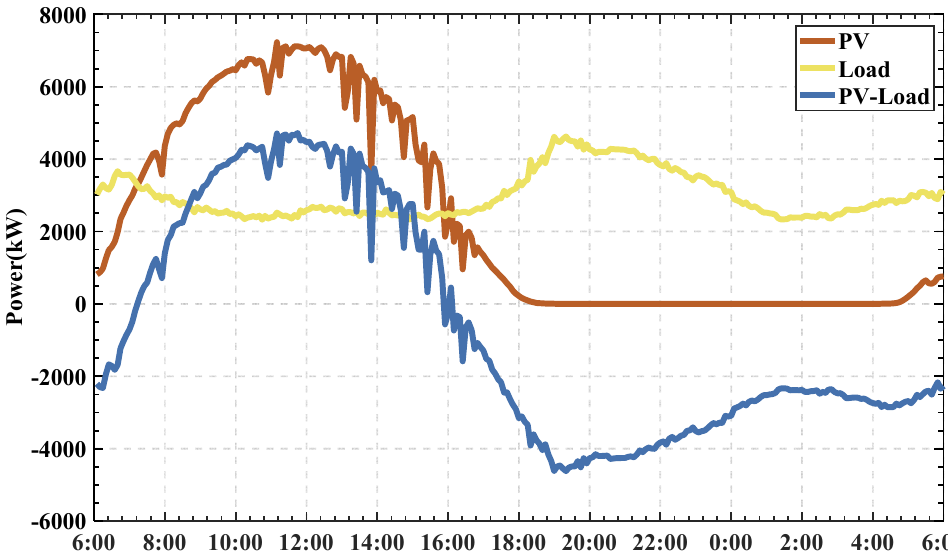
Figure 5. The data of the PVs and loads. Table 1. Units for Magnetic Properties.